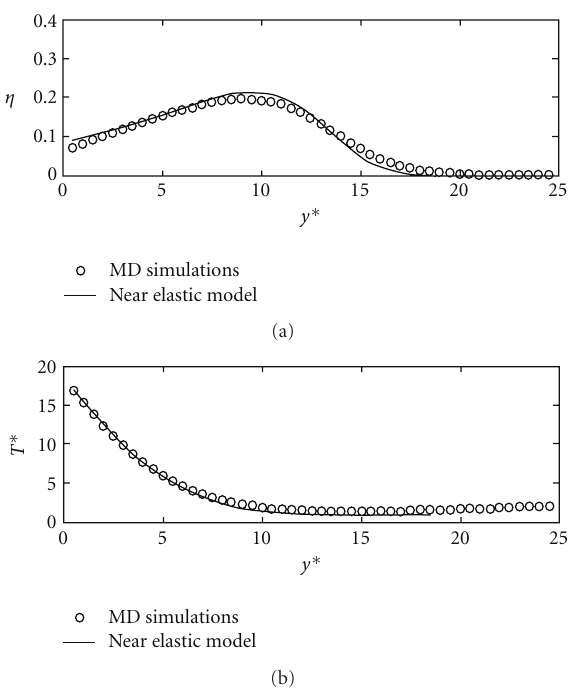
Figure 2: Comparison of (a) packing fraction and (b) granular tem- perature for near elastic model with MD simulations for V ∗ = 4 . 0.